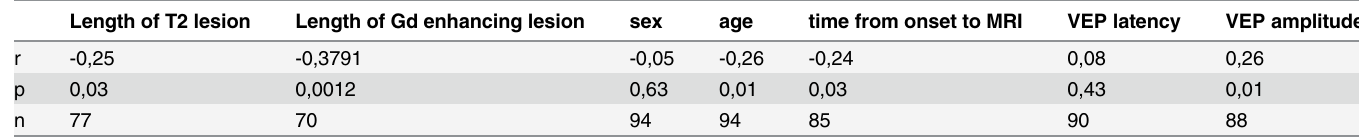
Table 6. Correlation between visual acuity after treatment and demographic, clinical, electrophysical and MRI parameters. Length of T2